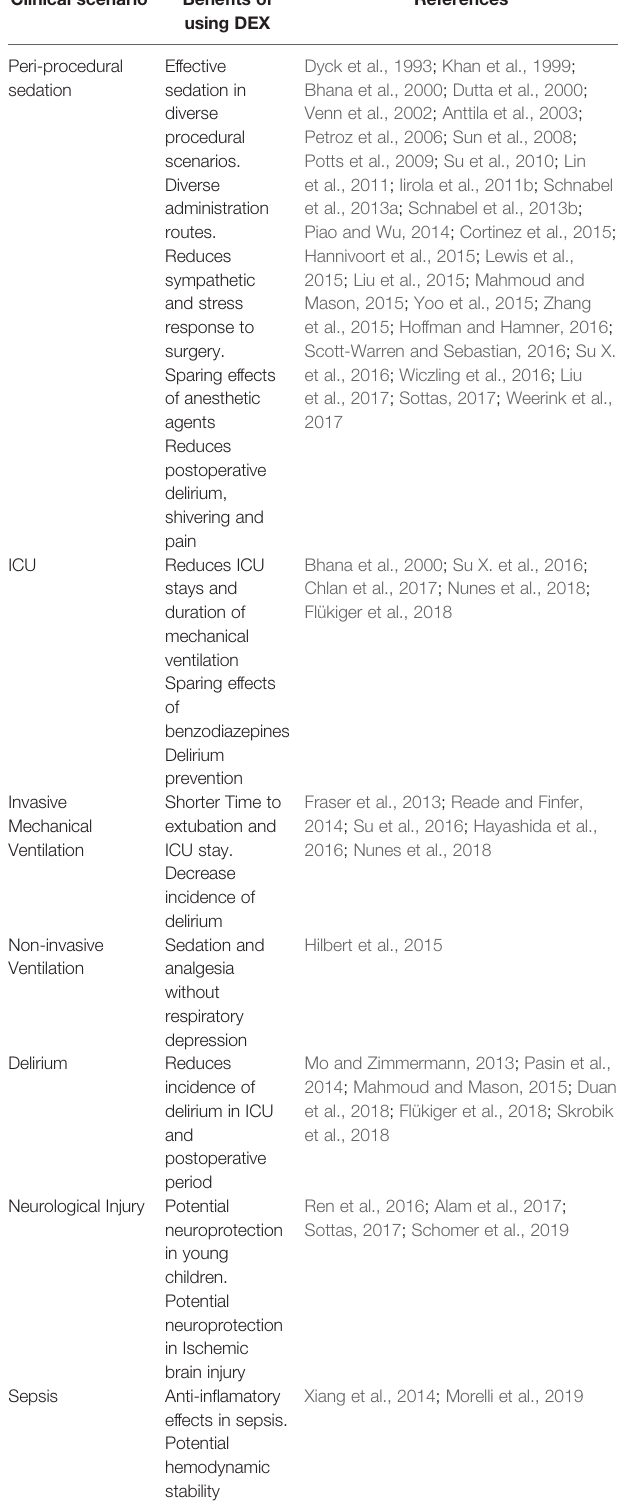
TABLE 3 | Bene fi ts of adding DEX in different clinical